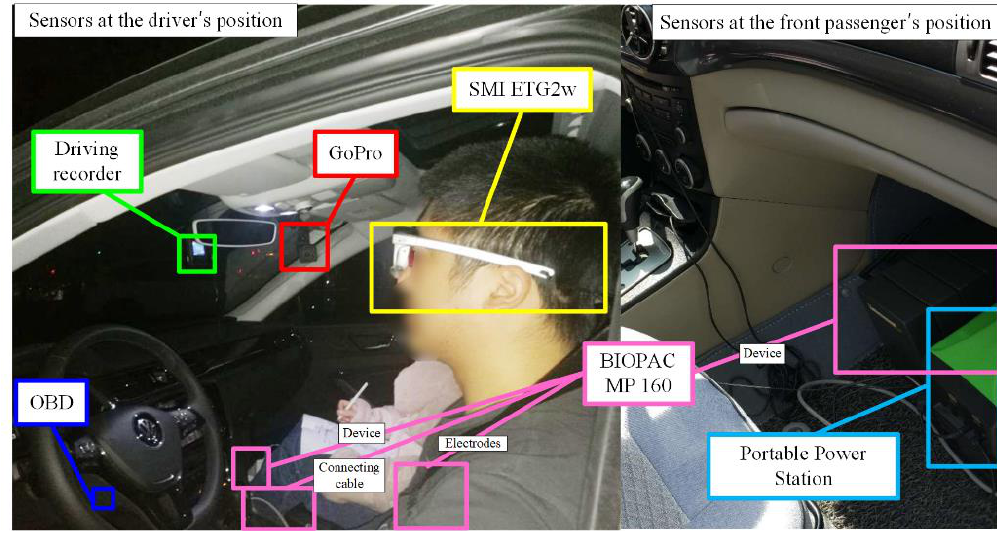
Figure 2. Equipment installation in the experiment.